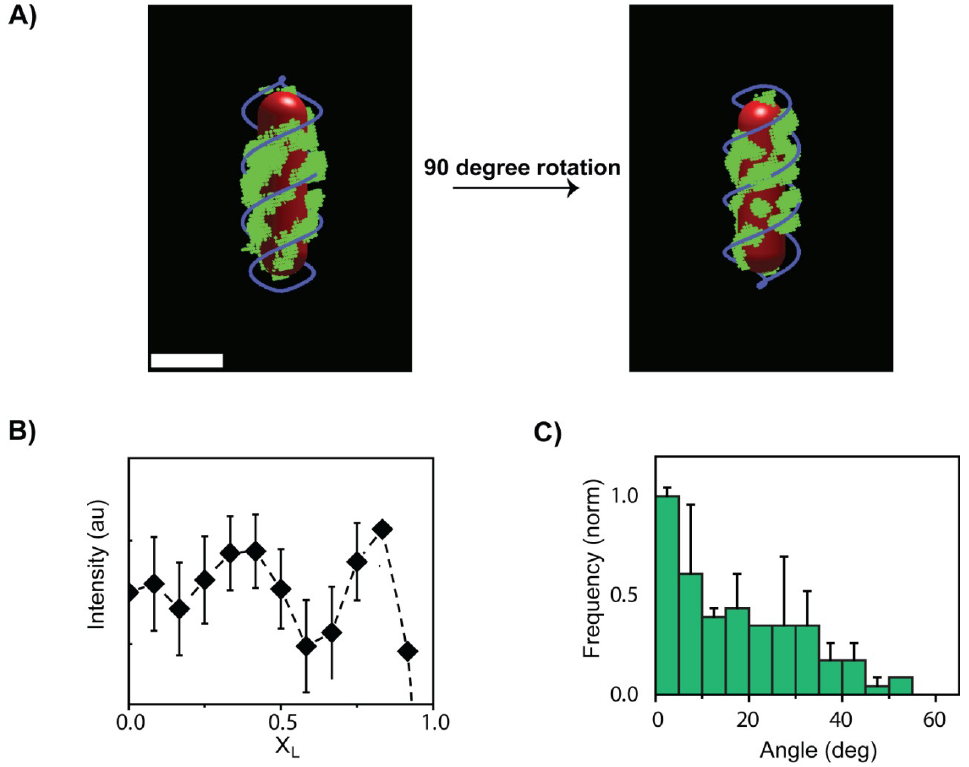
Figure 4. Arrangement of the LamB receptors network on cell surface. ( A ) One cell is shown. Rendered 3D image obtained by sectioning epifluorescence microscopy of cells with labeled receptors, showing nearly continuous helices (scale bar = 2 µ m). Quantum dots (green) were used to label the receptor and cell outline is in red. The pattern is described by two helices in blue. ( B ) Normalized LamB distribution along X averaged L for 50 cells. A clear peak at the cellular poles indicates of a high concentration of receptors. ( C ) Angular distribution of LamB bands from 98 cells, showing a tendency for band (perpendicular to the long axis). Adopted and modified orientation along the short axis X T after